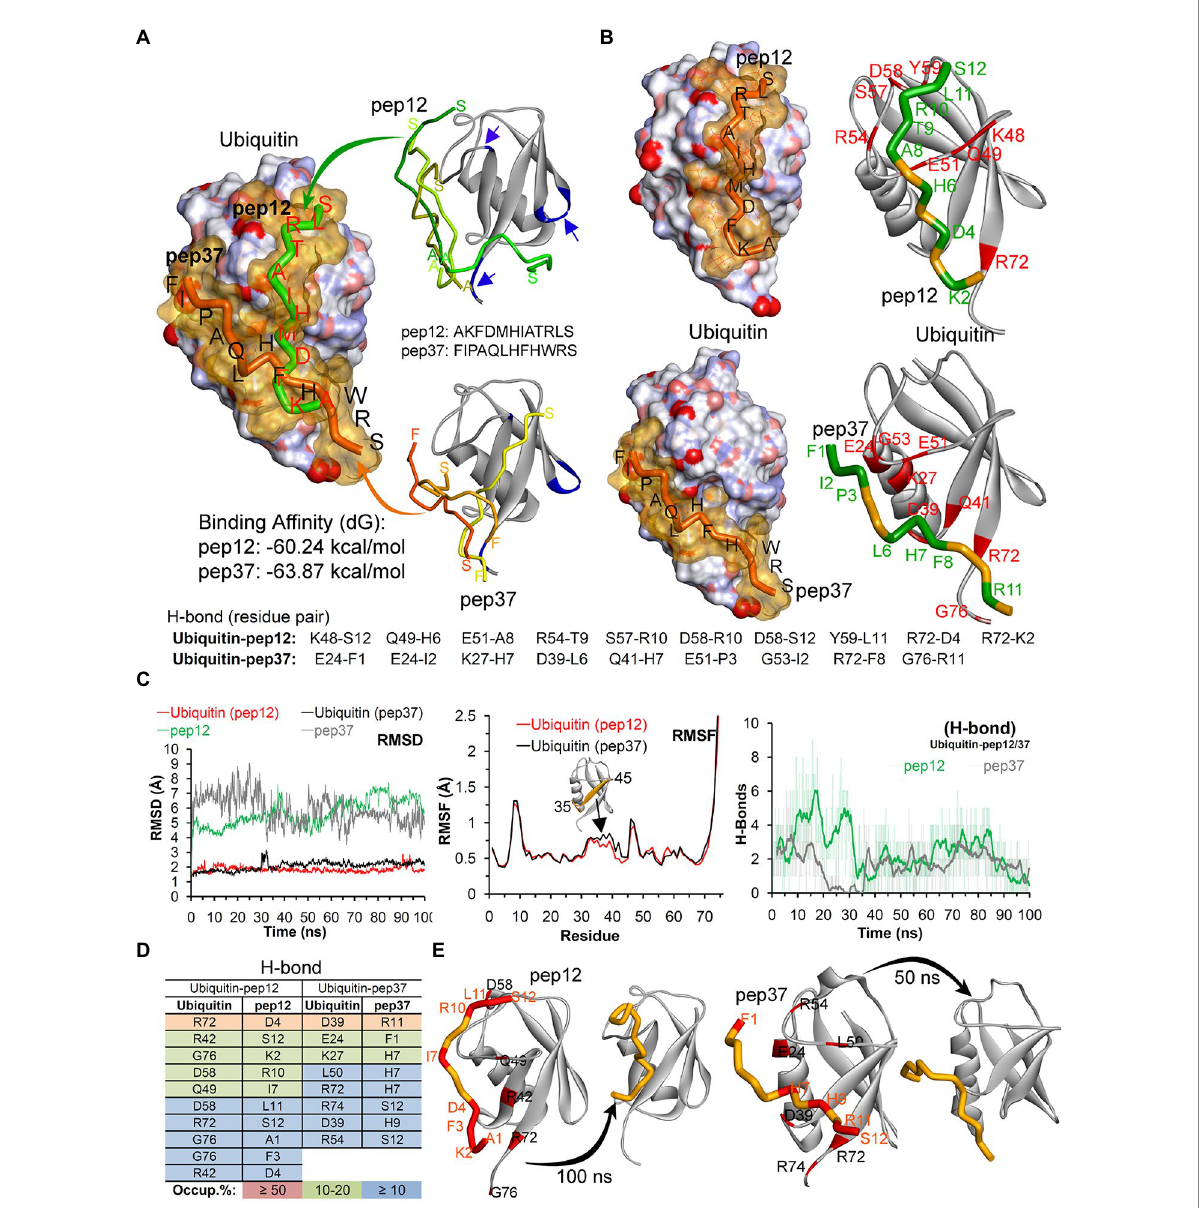
FIGURE 8 Model of peptide-12 and peptide-37 mediated inhibition of ubiquitination. (A) Peptides docked with ubiquitin having highest binding affinity are shown (blue arrows/region represent peptide-binding region traced in our NMR study). Although we were unable to determine whether the ubiquitin-binding peptides-12 or 37 bound to different or identical regions on ubiquitin, we analyzed potential conformations of peptide-12 and peptide-37 with ubiquitin by molecular dynamics simulation (MDS) and docking approaches. (B) The hydrogen bond (H-Bond) interaction map between amino acids of ubiquitin and peptides. (C) Structural changes and amino acid fluctuations identified for the Ubiquitin-peptide-12/ peptide-37 complex using RMSD (root-mean-square deviation) and RMSF (root-mean-square fluctuation) calculations. (D) The stable intermolecular H-bonds between ubiquitin-peptide-12/peptide-37 over 100 ns of MDS, and residues pair with occupancy ≥ 5% (from 100 ns) are listed. (E) Structural dynamics of peptide-12 and peptide-37 observed during MDS. *In this figure, the ubiquitin crystal structure PDB id.: 1UBQ (60) in apo/inactive form was used, and ubiquitin is represented as atom charge surface/solid ribbon and pep12/pep37 are presented as tubes. Ubiquitin has a compact and rigid structure that ends in a flexible C-terminal tail. This rigid conformation allows only certain residues to have limited flexibility to permit a large diversity of protein–protein interactions (Komander and Rape, 2012; Ernst et al., 2013). It contains a hydrophobic core formed divided in three areas: the first one around Ile44, Leu8, Val70 and His68 is involved in most of the interactions with ubiquitin-binding proteins (UBP) and the proteasome (Sloper-Mould et al., 2001; Dikic et al., 2009); the second patch, around the residues Ile36, Leu71 and Leu73 is important for recognition by some HECT E3 ligases (Kamadurai et al., 2009). Finally, the area around Gln2, Phe4 and Thr14 interacts with certain proteins including some DUBs (Hu et al.,